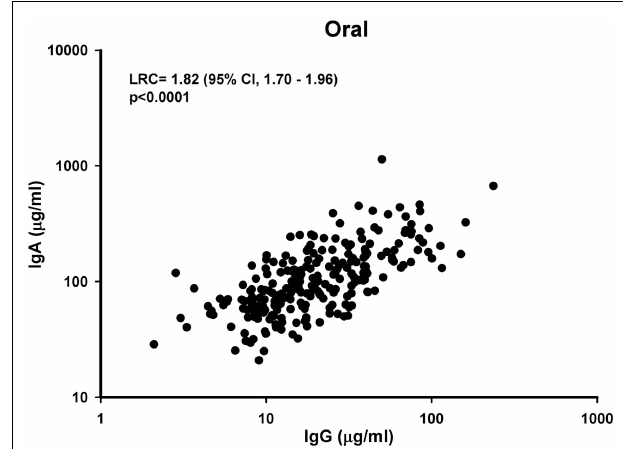
FIGURE 1 |Association of oral IgG to oral IgA levels. Oral samples collected from the three phases of the menstrual cycle from 85 participants were measured for IgG and IgA levels.The graph represents a scatter plot of untransformed levels of oral IgG and IgA from all three phases of the menstrual cycle from each participant, and a p -value < 0.05 was considered significant. LRC, Linear Regression